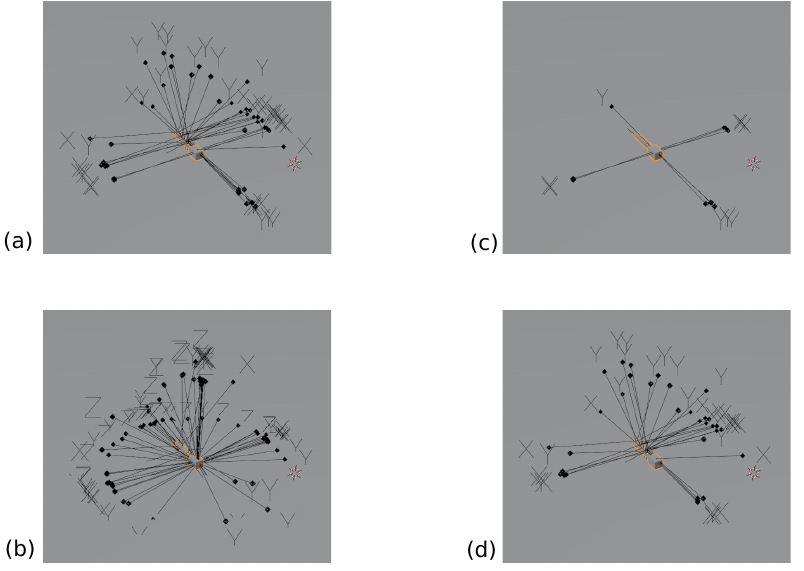
Figure 2. Proximity-based classification of pick grasps visualized inside Blender: ( a ) pick grasps, ( b ) place grasps, ( c ) valid grasps out of all the pick grasps, ( d ) invalid grasps out of all the pick